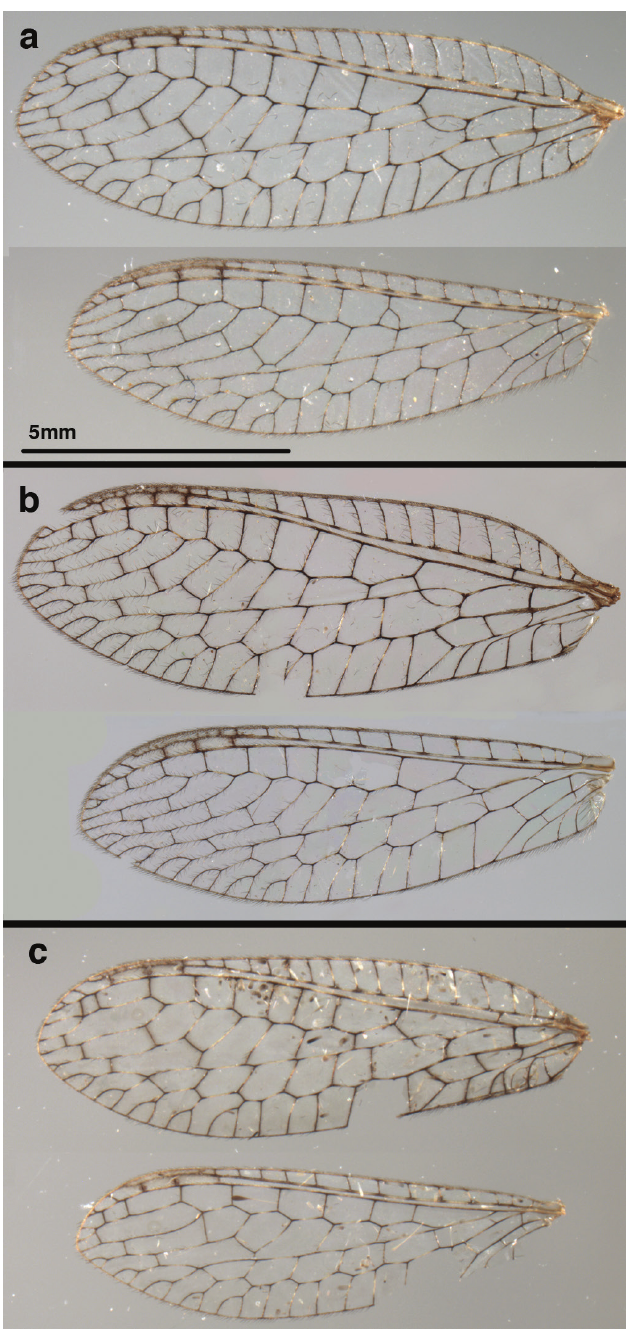
Figure 104. Ungla argentina (Navás): Variation in size, shape, coloration, venation of forewings and hindwings (Argentina; a Catamarca, male, CAS; b Santiago del Rio, female, CAS; c La Rioja, male, CAS). Scale applies to all